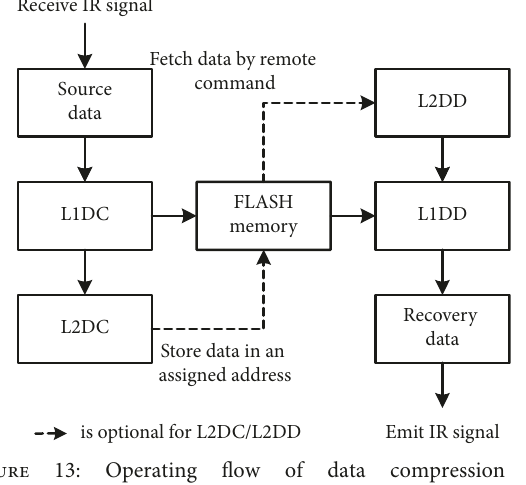
Figure 13: Operating flow of data compression and decompression.